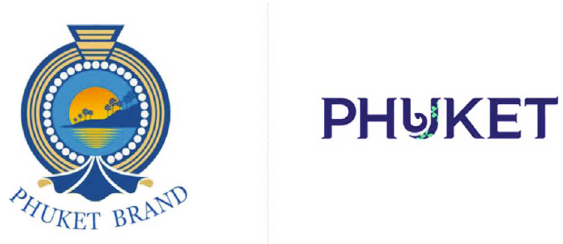
Figure 4: Tourist signs of